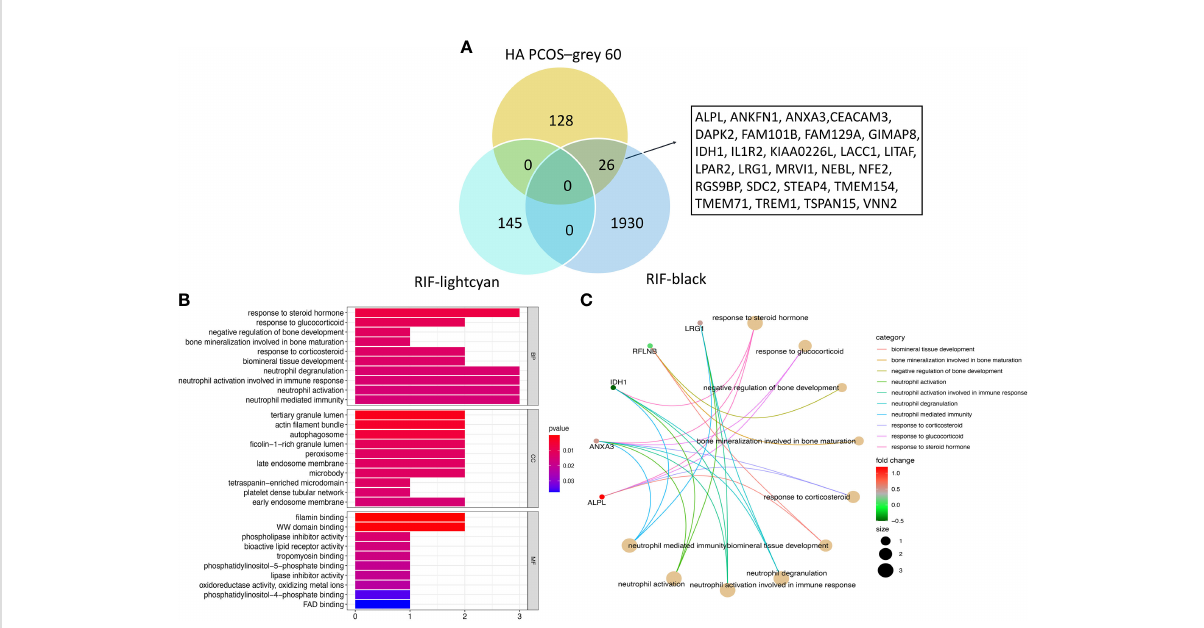
FIGURE 4 Shared gene signatures between HA PCOS and RIF. (A) The 26 shared gene signatures between grey60 module of HA PCOS and lightcyan and black modules of RIF. (B) GO enrichment analysis of biological process, molecular functions and cellular components for shared gene signatures. (C) Circos plot shows the relationship between genes and GO terms of biological process.